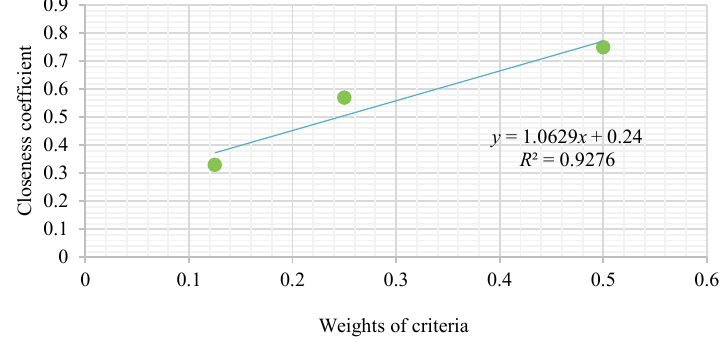
Fig. 7. Analysis of the success of European